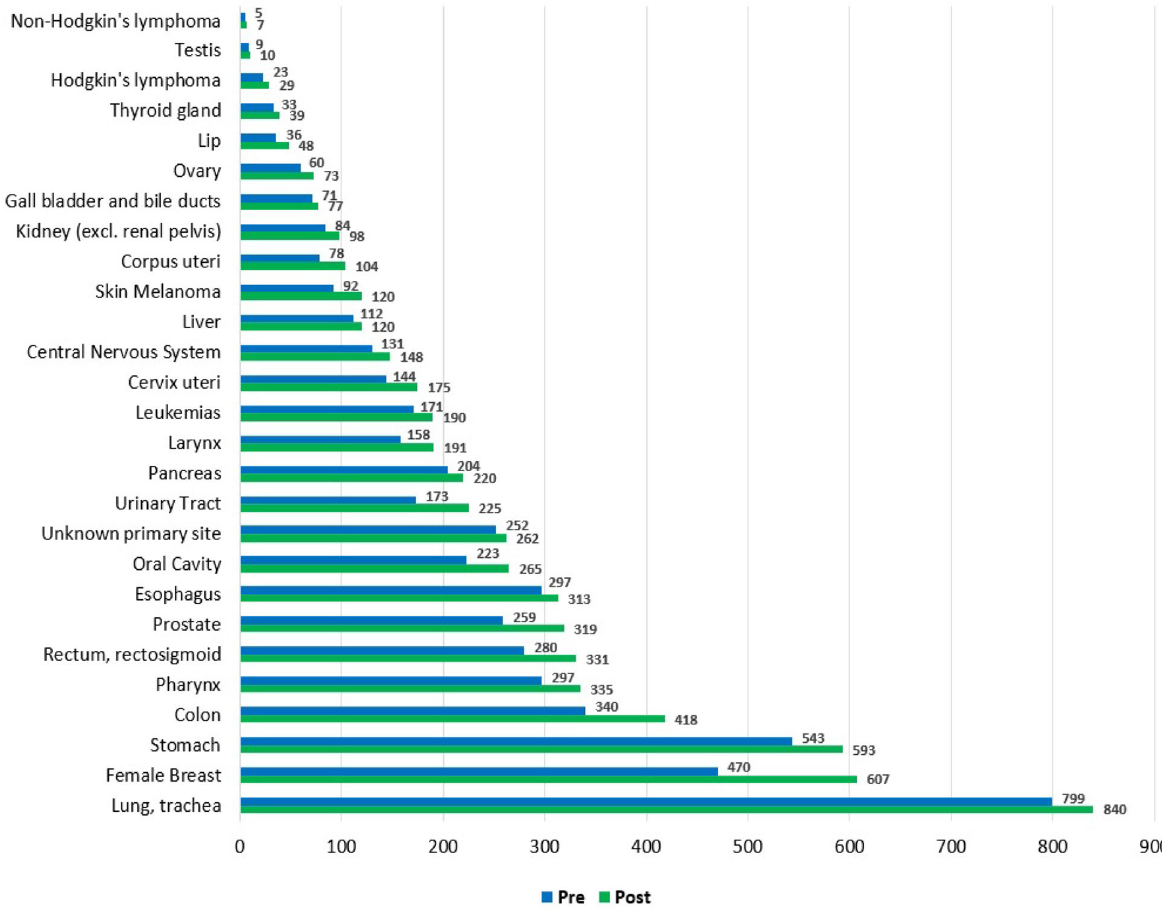
Figure 2. Comparison of the absolute number of deaths from both databases for each tumour site